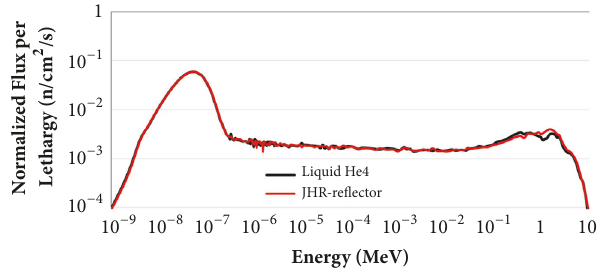
Figure 23: Effect of a 3 cm thick liquid 4 He layer on the neutron spectrum.